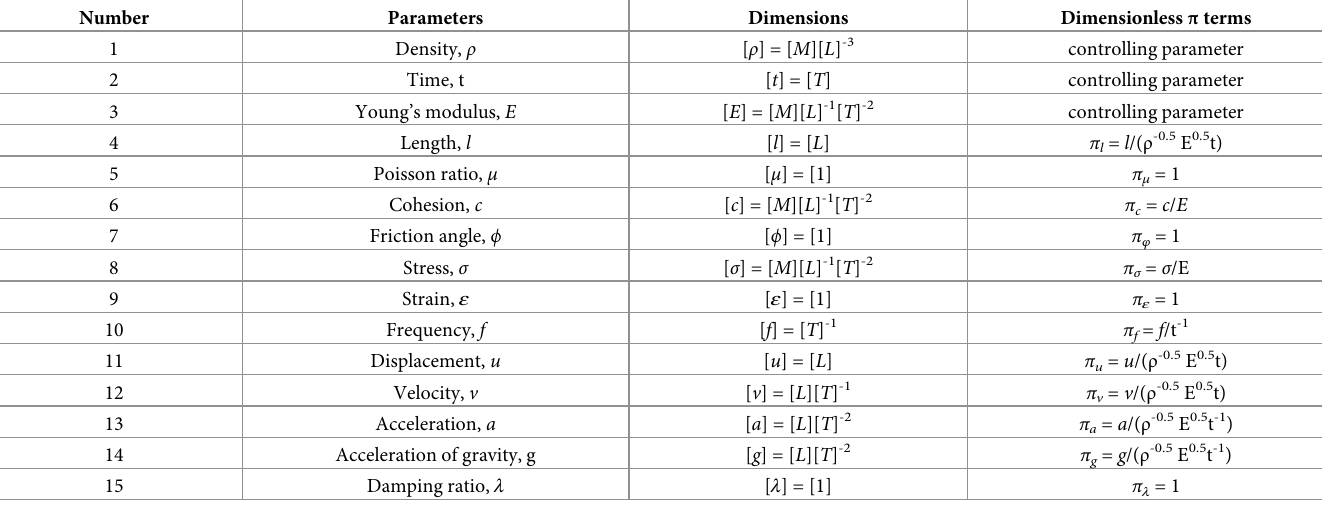
Table 1. Dimensions and dimensionless π terms of key parameters considered in similitude (mass [ M ], length [ L ], time [ T ] are the fundamental dimensions). Number Parameters